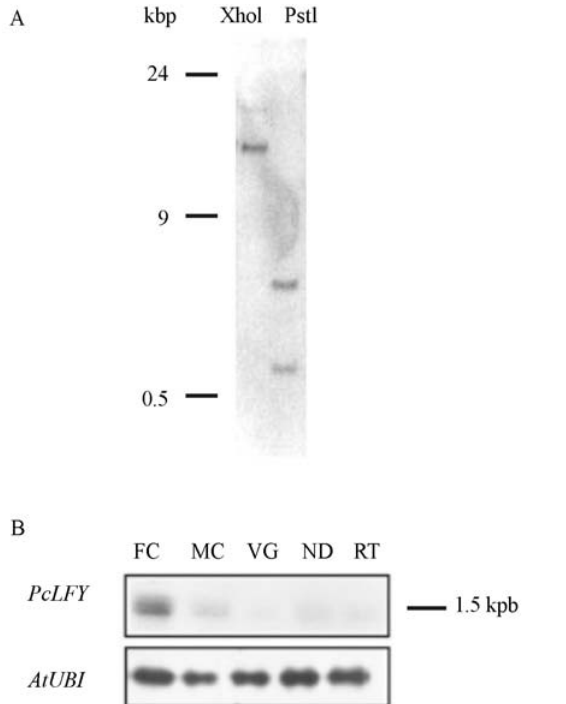
Figure 4 - A. Southern blot of genomic DNA from P. caribaea var. caribaea probed with PcLFY . Lane 1: digested with Xho I; lane:, digested with Pst I. B . Northern blot made with total RNA extracted from develop- ing female cones (FC), developing male cones (MC), vegetative apices of juvenile plants (VG), young leaves (needles) of adult plants (ND), and seedling roots (RT), probed with PcLFY . The same blot was re-probed at low stringency with a heterologous Arabidopsis ubiquitin sequence (AtUBI) to show uniform loading and transfer of all lane